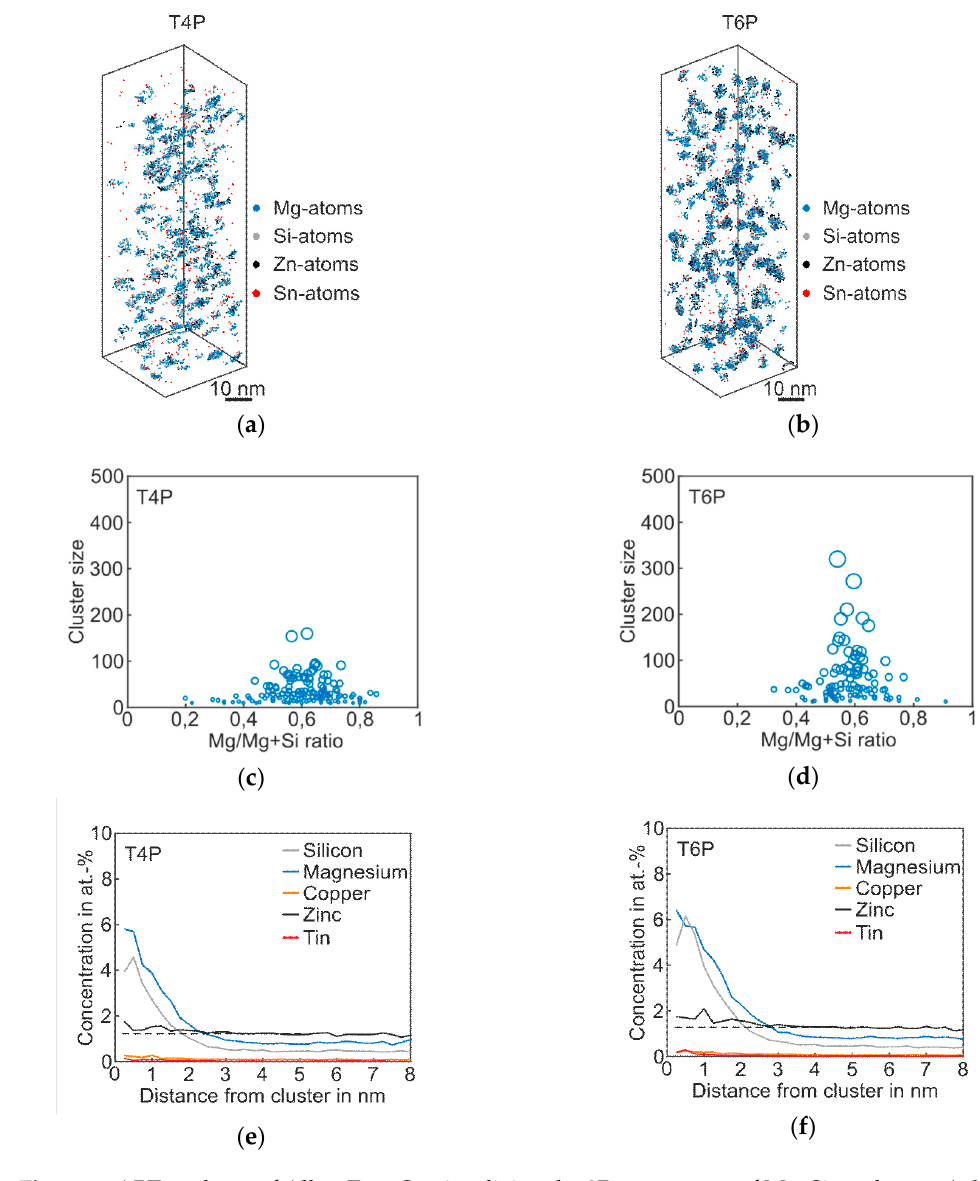
Figure 5 . APT analyses of Alloy Zn + Sn visualizing the 3D atom maps of Mg–Si co-clusters ( a , b ) in T4P and T6P conditions. The corresponding cluster size distributions and proxigrams are shown in ( c – f ). The different circle diameters in ( c ) and ( d ) indicate the cluster size. The dotted lines in ( e , f ) reflect the matrix concentration level of Zn.